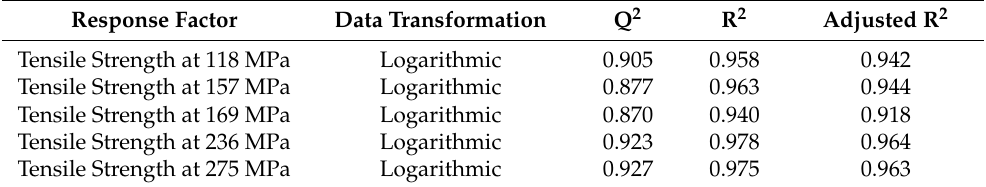
Table 10. Overview of fit statistics regarding tensile strengths obtained during compression- force